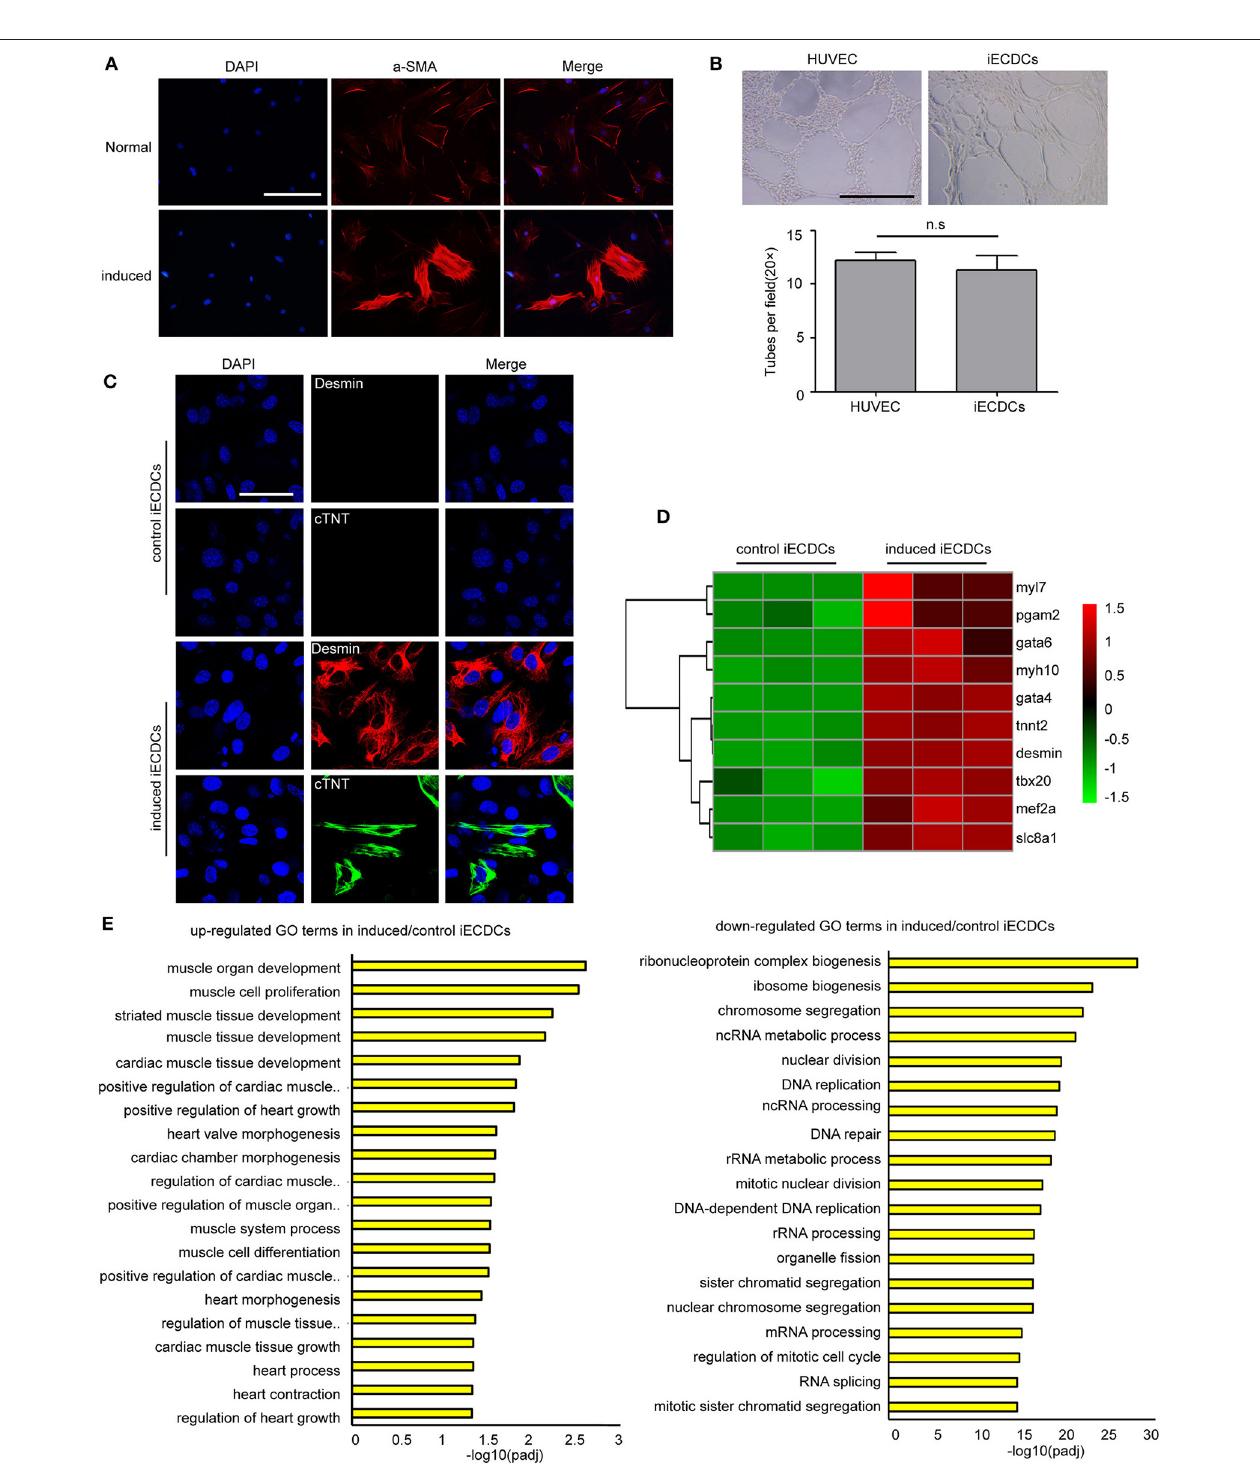
FIGURE 4 | Cardiovascular differentiation potential of iECDCs in vitro . (A) Immunostaining of iECDCs with a-SMA pre- and postsmooth muscle differentiation induced by TGF- β 1 and PDGF- β (scale bar = 100 µ m). (B) Analysis of blood vessel network formation after 6h culture on Matrigel of HUVEC and iECSCs ( n = 8, two-tailed t -test). (C) Confocal imaging of cardiac marker proteins desmin and cTNT in induced iECDCs (scale bar = 100 µ m). (D) Heatmap analysis of cardiomyocyte-related genes to compare induced iECDCs with normal iECDCs. Expression levels were identified with different colors in which red represents upregulation and green represents downregulation. (E) The Gene ontology (GO) analysis results up- and downregulated GO terms in induced iECDCs vs. normal iECDCs based on the RNA sequencing assay ( n = 3, * p < 0.05, two-tailed t -test).